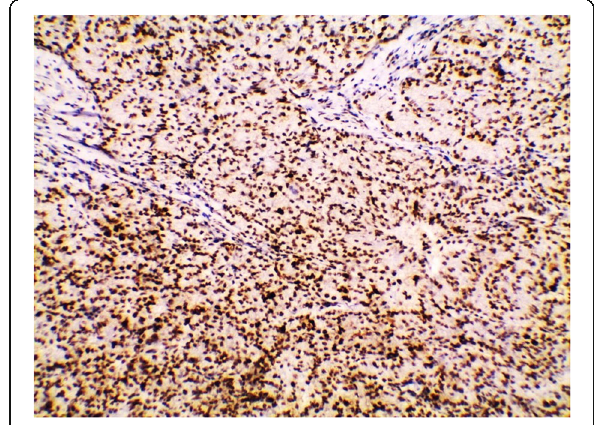
Fig. 4 Positive nuclear Ki-67 expression in poorly differentiated gastric carcinoma (×200)